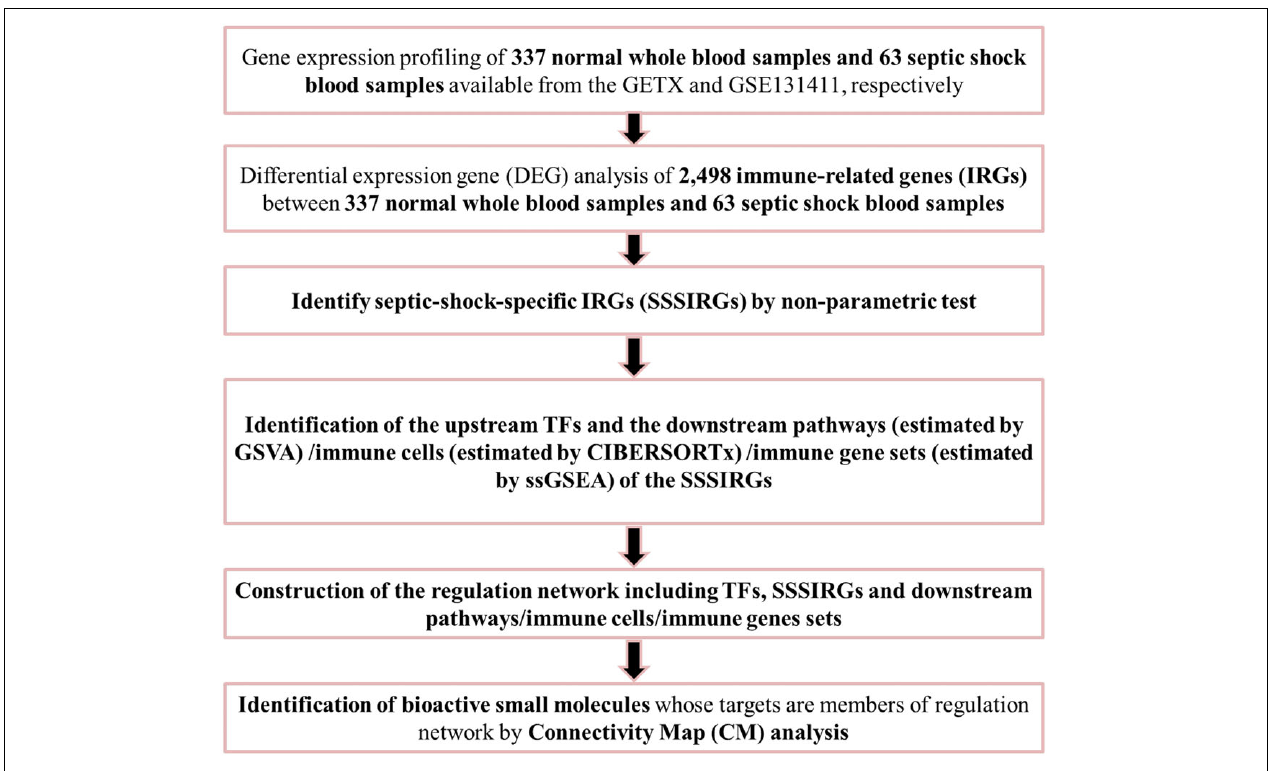
FIGURE 1 | The flowchart of all analysis